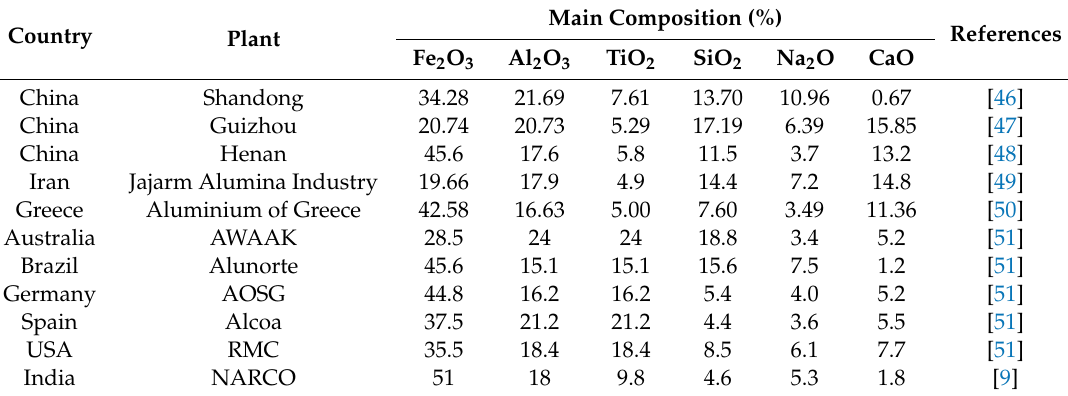
Table 1. Main chemical compositions of Bayer process RM in di ff erent plants worldwide (%, w / w ). Country